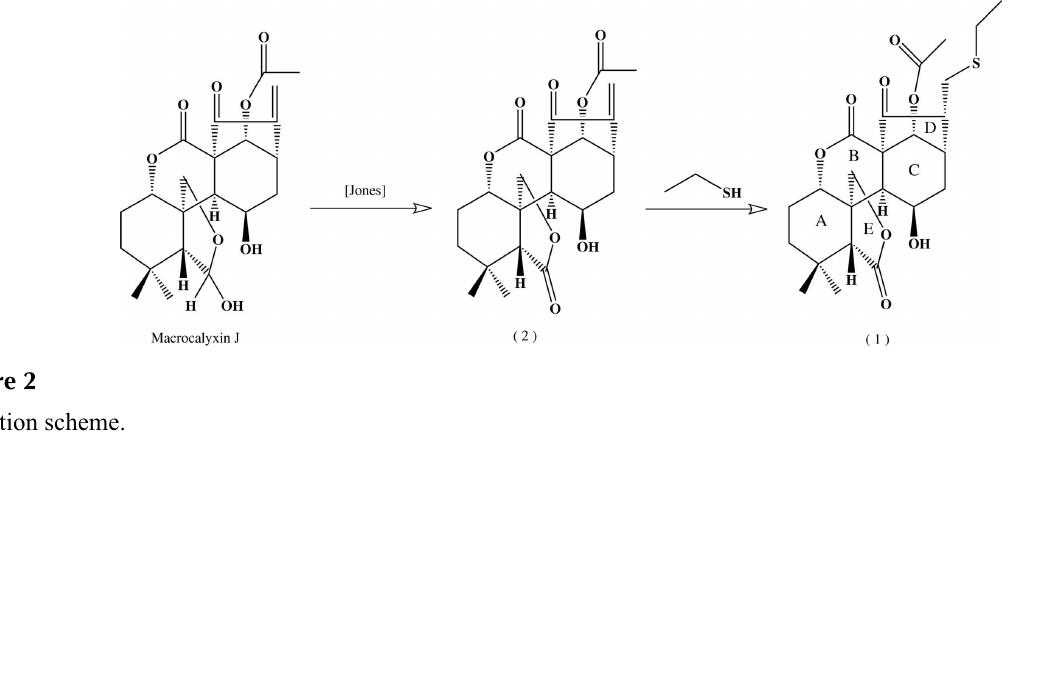
The structure of (1) showing atomic numbering scheme and 30% probability displacement ellipsoids. The ethylthio group is disordered over three